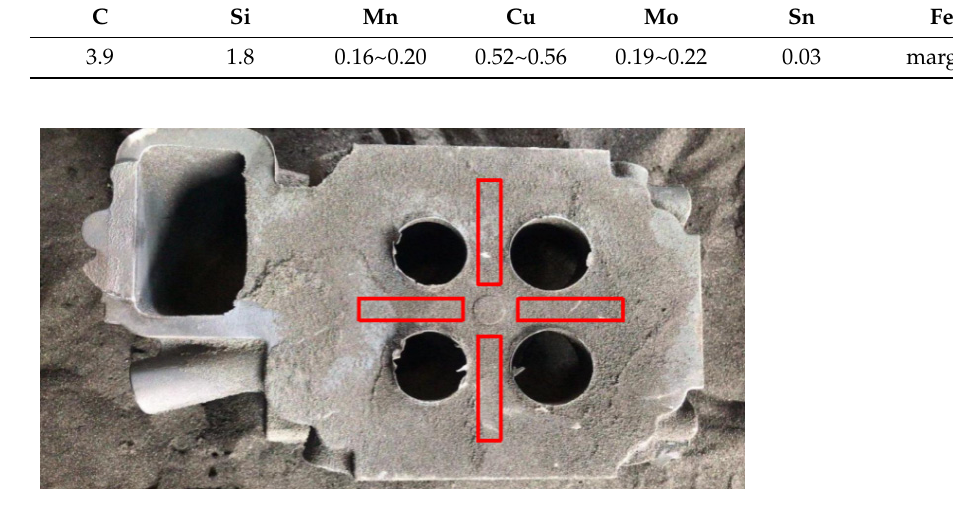
Figure 1. Cylinder head after casting and schematic diagram of sampling location.